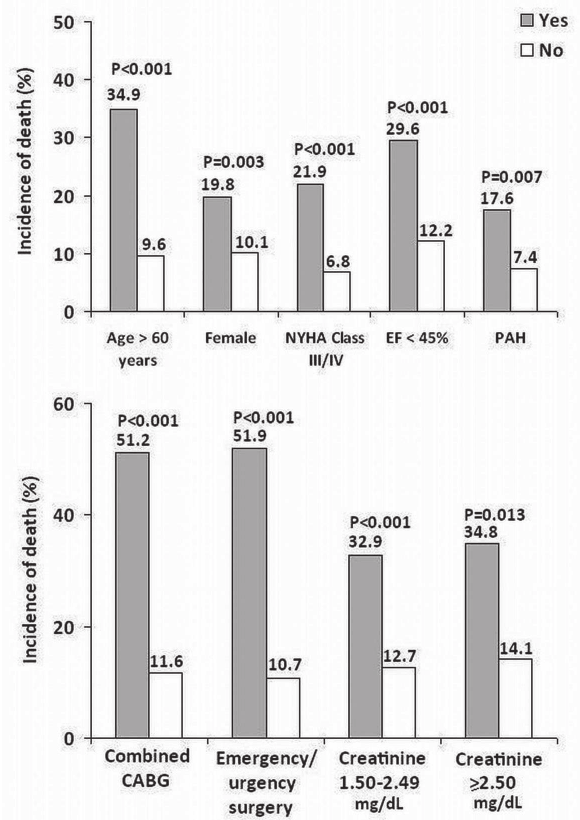
Fig. 1 - Association of clinical characteristics with the occurrence of death after heart valve surgery (univariate analysis). EF - ejection fraction; CABG - coronary artery bypass